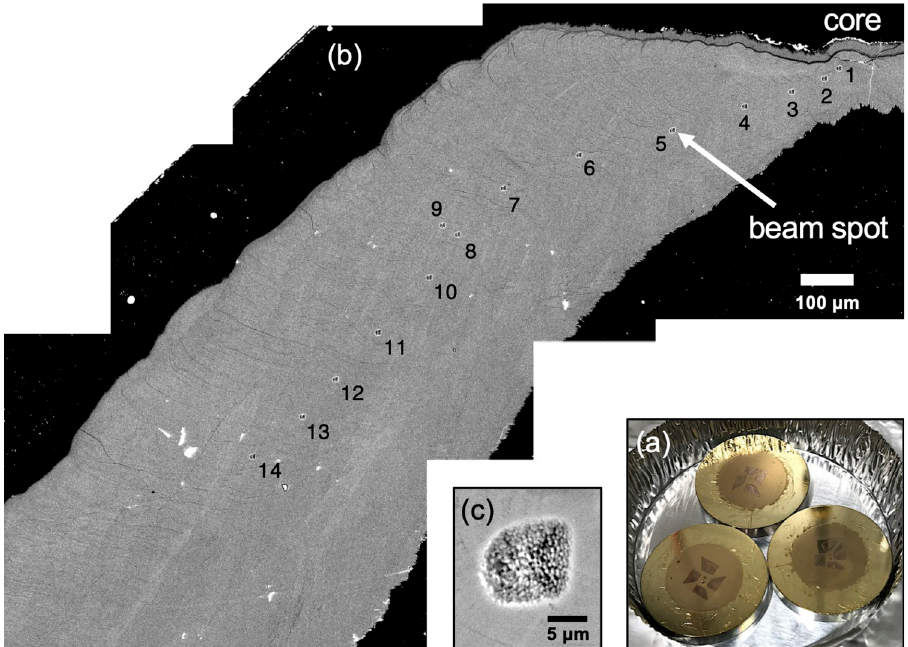
Fig 3. SIMS analysis of the otoliths of Pacific bluefin tuna. (a) Gold-coated indium mount containing 2 pieces of calcite UWC-3 standard and 4 otolith thin sections. (b) Cross-sectional image of an otolith taken with an electron probe micro analyzer under scanning electron microscope mode. SIMS beam spots are indicated by numbers. (c) An ion microprobe spot sputtered with a 133 Cs + primary ion beam focused to a diameter of 10 μ m.